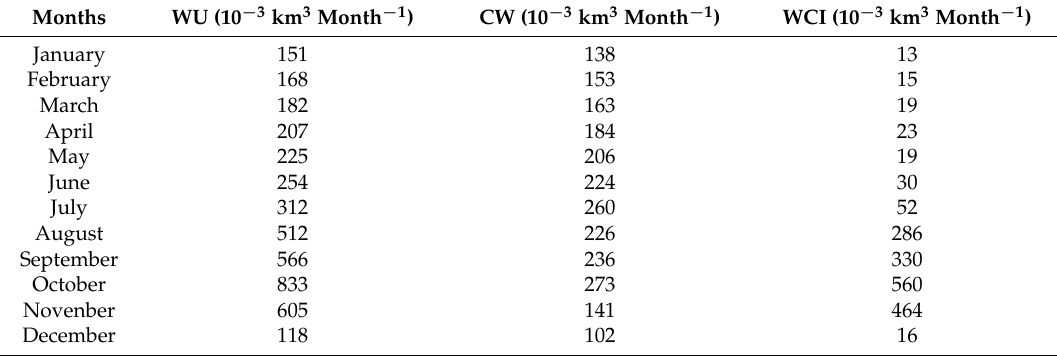
Table 3. Monthly water contribution from irrigated fields (WCI) (km 3 month − 1 ) (WU is defined as the total withdrawn water, CW is the consumptive water used and WCI is water contribution from irrigation refers to return flow from irrigated